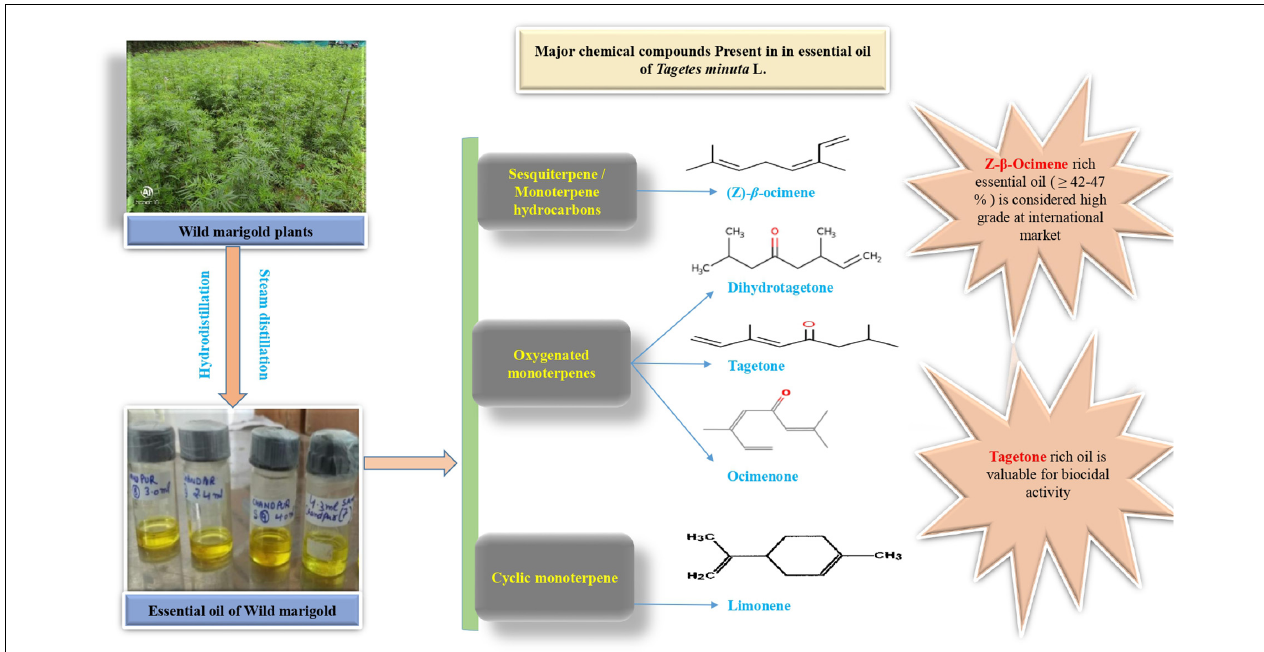
FIGURE 2 | Major chemical compounds present in the essential oil of wild